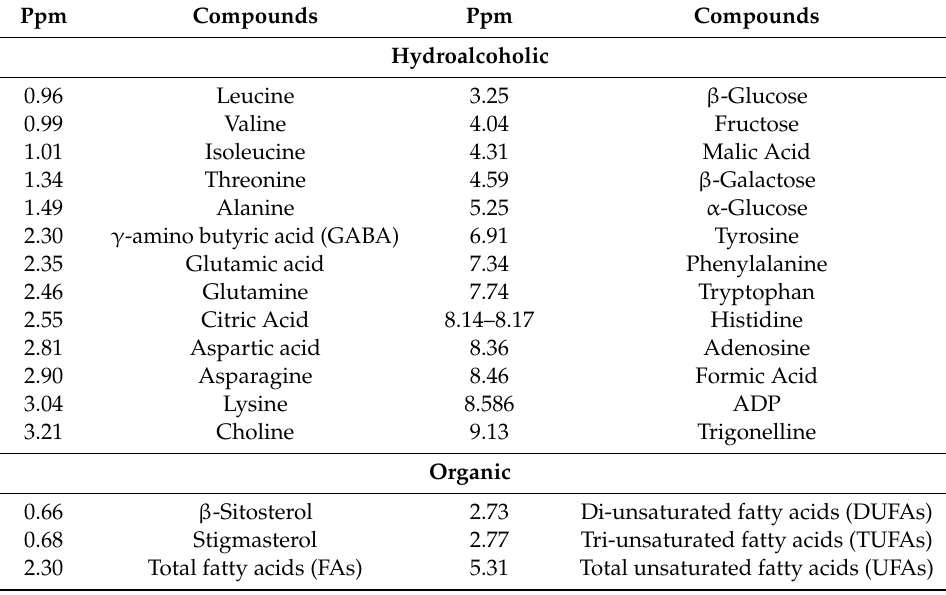
Table 2. Compounds and relative signals ( δ ( 1 H), ppm) selected for quantitative analysis in the hydroalcoholic and organic